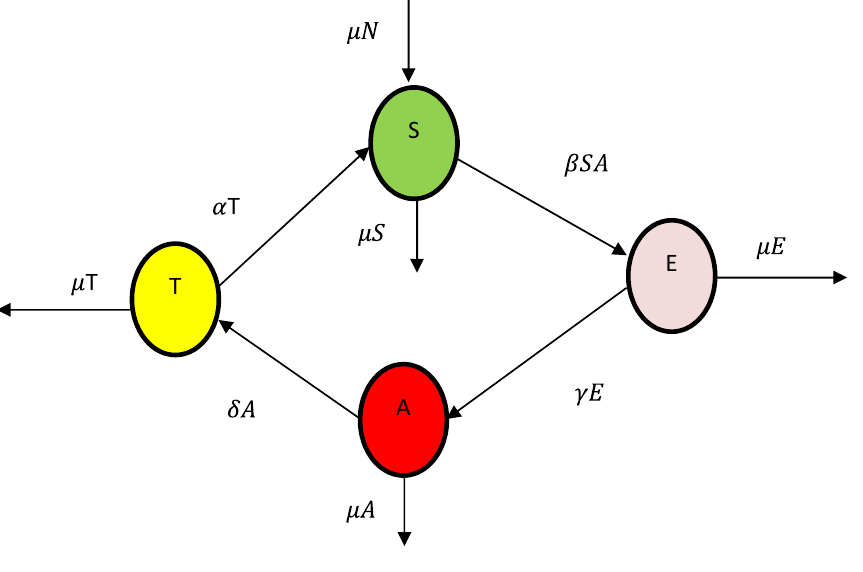
Figure 1. Schematic diagram for flow of the students’